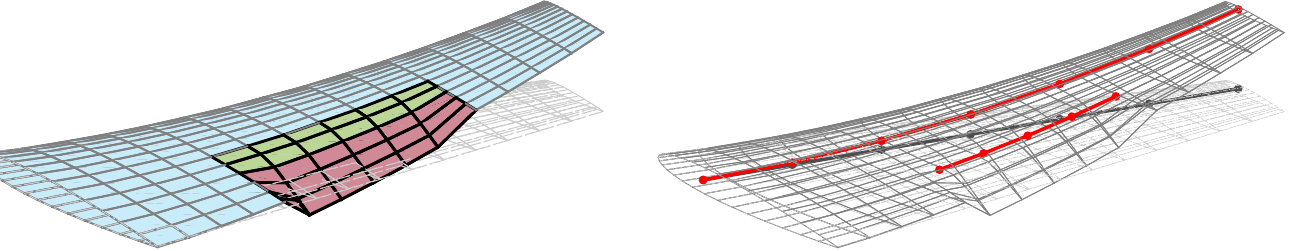
Figure 6. Control surface deflection for a deformable